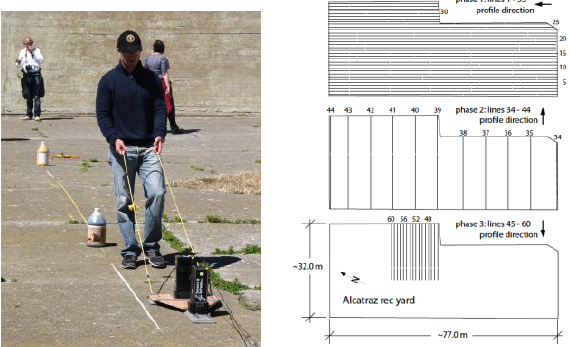
Figure 8. ( left ) GPR data acquisition in cross-dipole mode; ( right ) GPR survey geometry